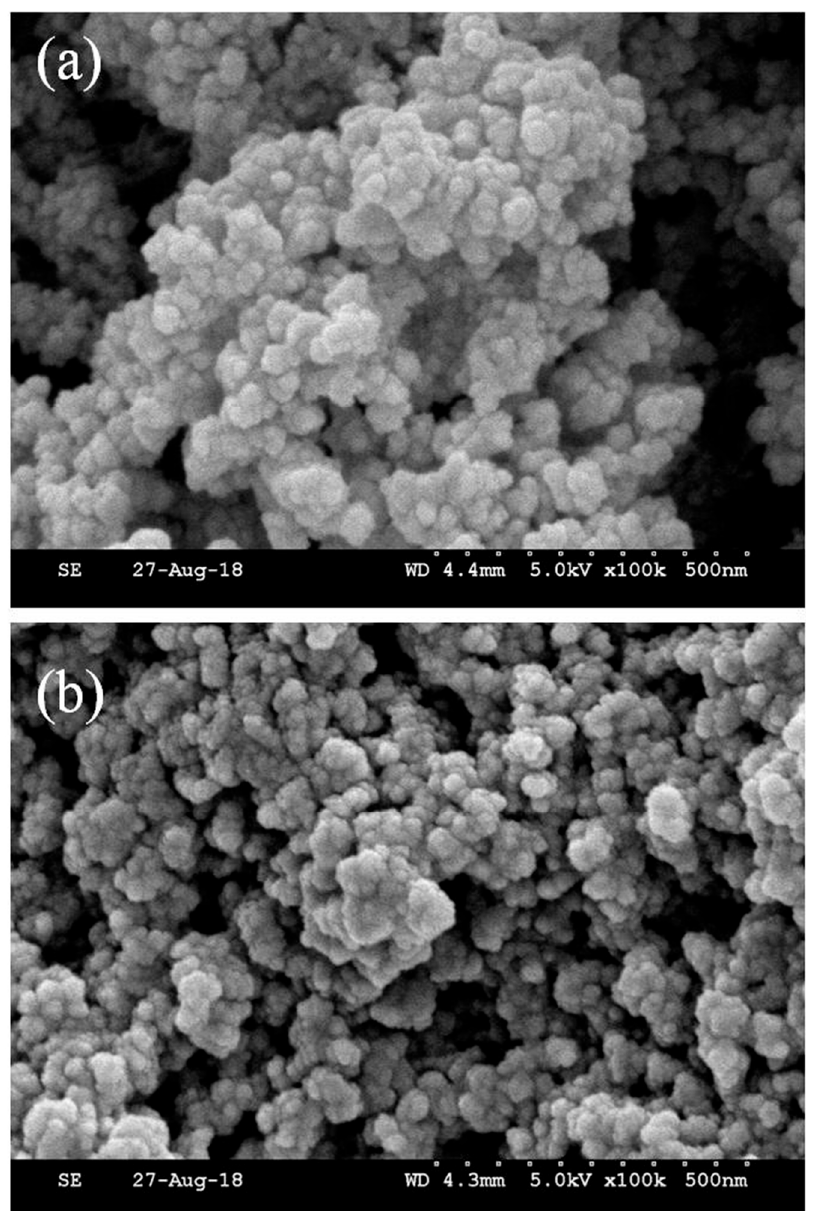
Figure 5. SEM images of HMICS with DES, ( a ), and NICS without DES ( b ).